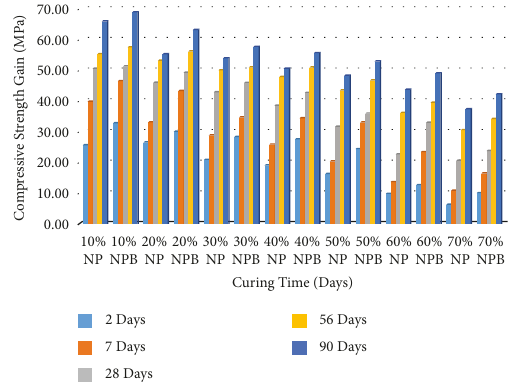
Figure 6: Compressive strength of OPC blended with NP (w/c 0.5). (cid:30)